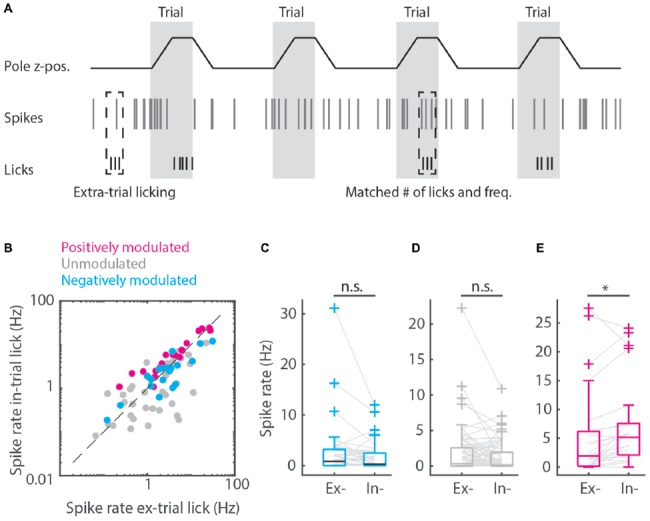
Matched extra-trial and intra-trial licks reveals the contribution of context to spike rate modulation. (A) Schematic representation of the procedure of matching behavioral statistics in which extra-trial licking bouts are matched with intra-trial licking bouts based on comparable number of licks and licking frequency to parse out the contribution of context to spike rate modulation. (B) Scatterplot of spike rates during intra-trial licking bouts vs. spike rates during extra-trial licking bouts for the positively modulated (magenta), unmodulated (gray) and negatively (cyan) modulated populations. (C,D) The negatively modulated population (C) and unmodulated population (D) did not show spiking rate modulations for matched intra- and extra-trial licking bouts, indicating that context is not involved in spike rate modulation for these populations. (E) The spiking rate of the positively modulated population was significantly higher during intra-trial than during extra-trial licking bouts, which is supportive evidence for the hypothesis that context is an important contributor to spike rate modulation for this population of medial prefrontal cortex (mPFC) units. n.s. not significant (p > 0.05), *p < 0.05.